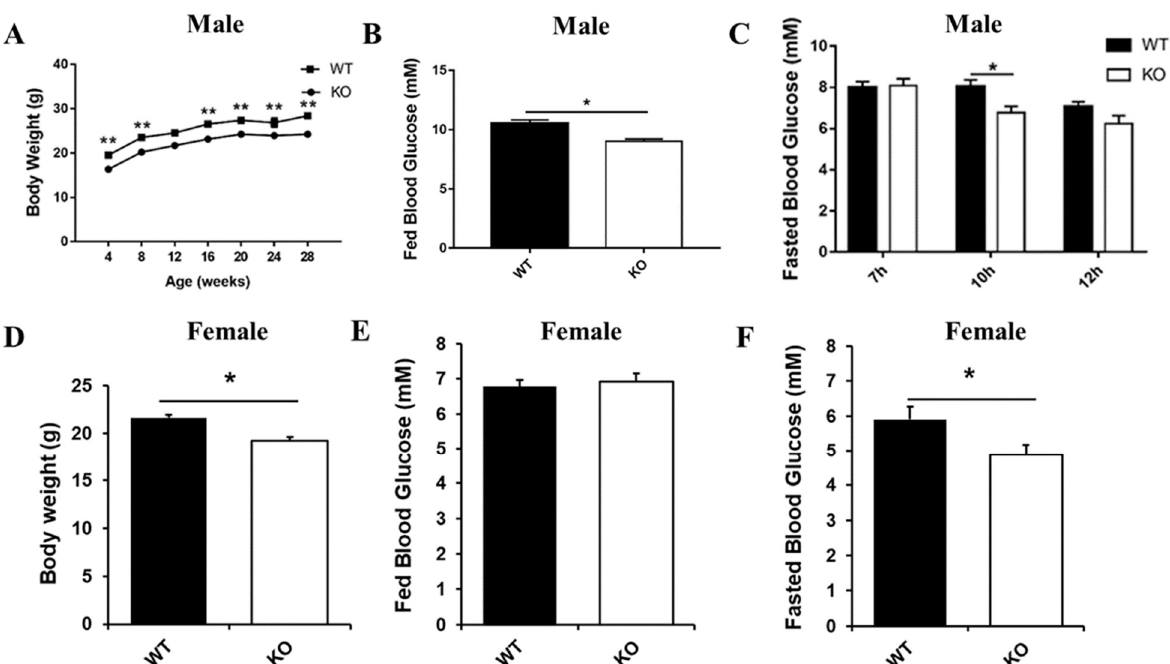
Figure 2. Metabolic phenotype analysis of Selenot -KO mice. Body weight ( A ) and fed blood glucose levels ( B ) of male KO and WT mice ( n = 5). ( C ) The blood glucose levels of male KO and WT mice after fasting of different duration ( n = 5). Body weight ( D ), fed blood glucose levels ( E ) and 10 h-fasting blood glucose levels ( F ) of female KO and WT mice ( n = 6). Data were presented as means ± SEM. * p < 0.05, ** p < 0.01, compared with KO mice; ANOVA followed by a Mann–Whitney nonparametric U test.